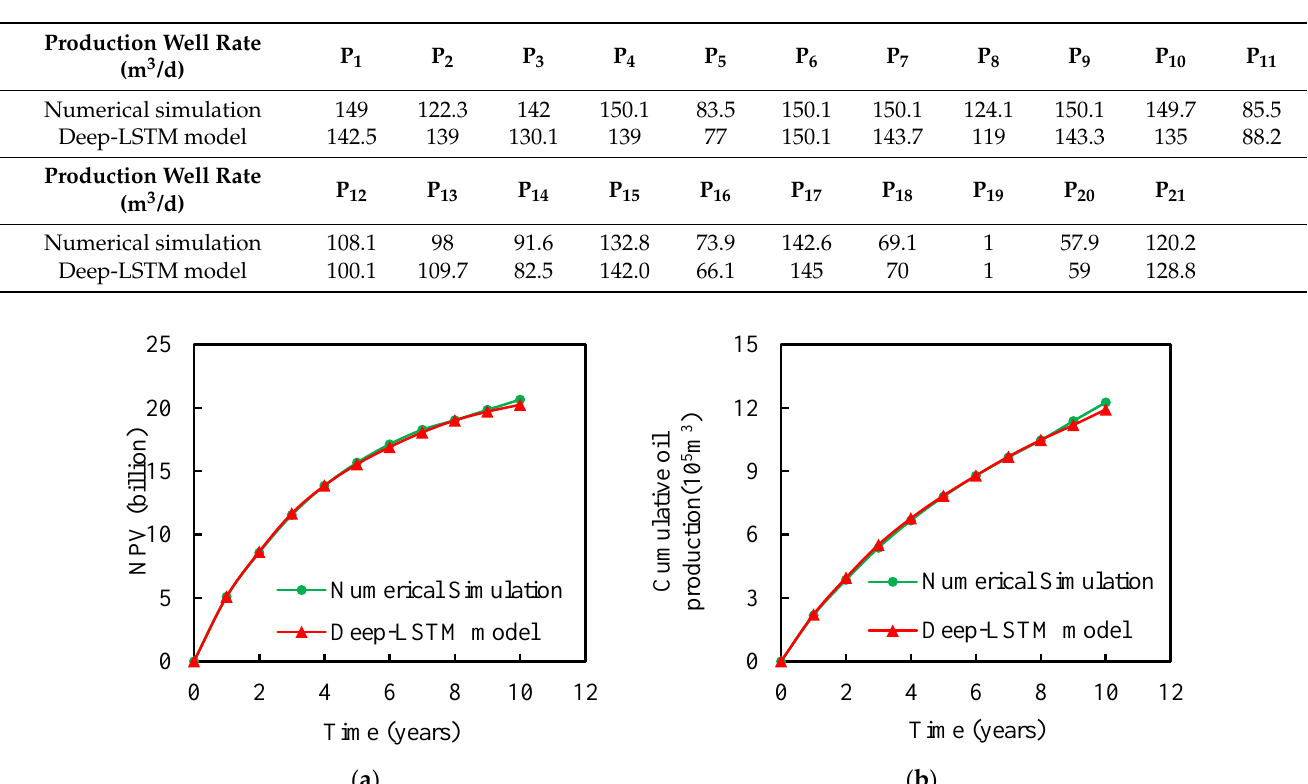
Table 9. Comparison of optimization results of 21 production wells.